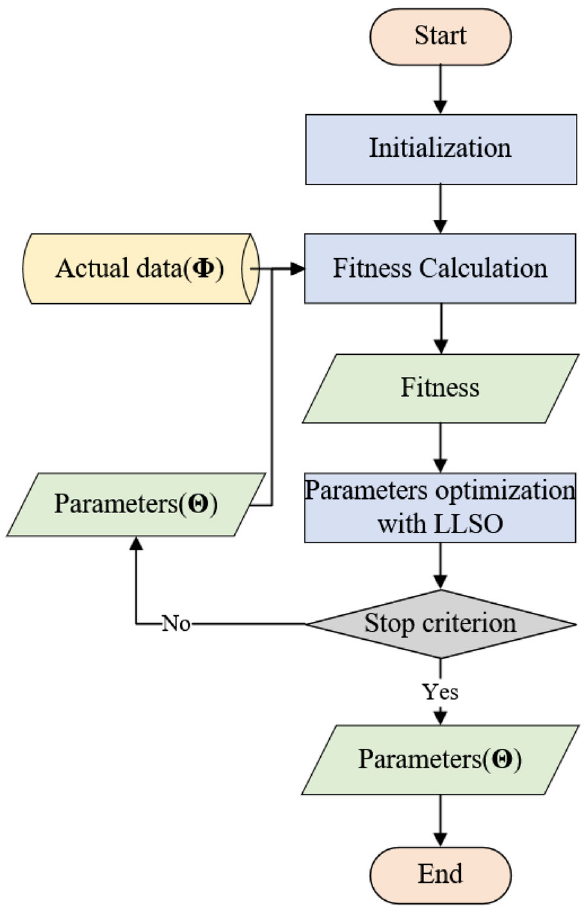
Fig. 2 Flow chart of the simulation